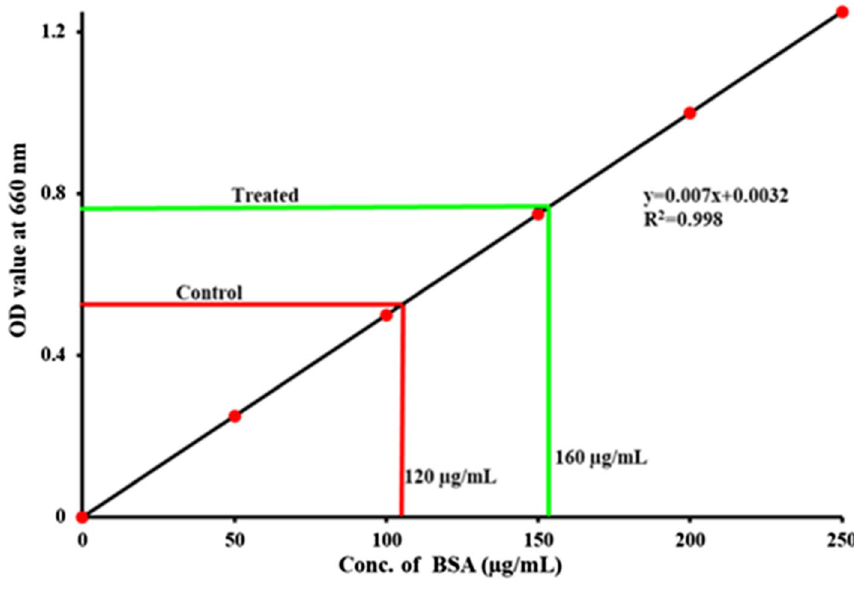
Fig. 6 Determination of chloro- phyll content from microalgae Chlorella